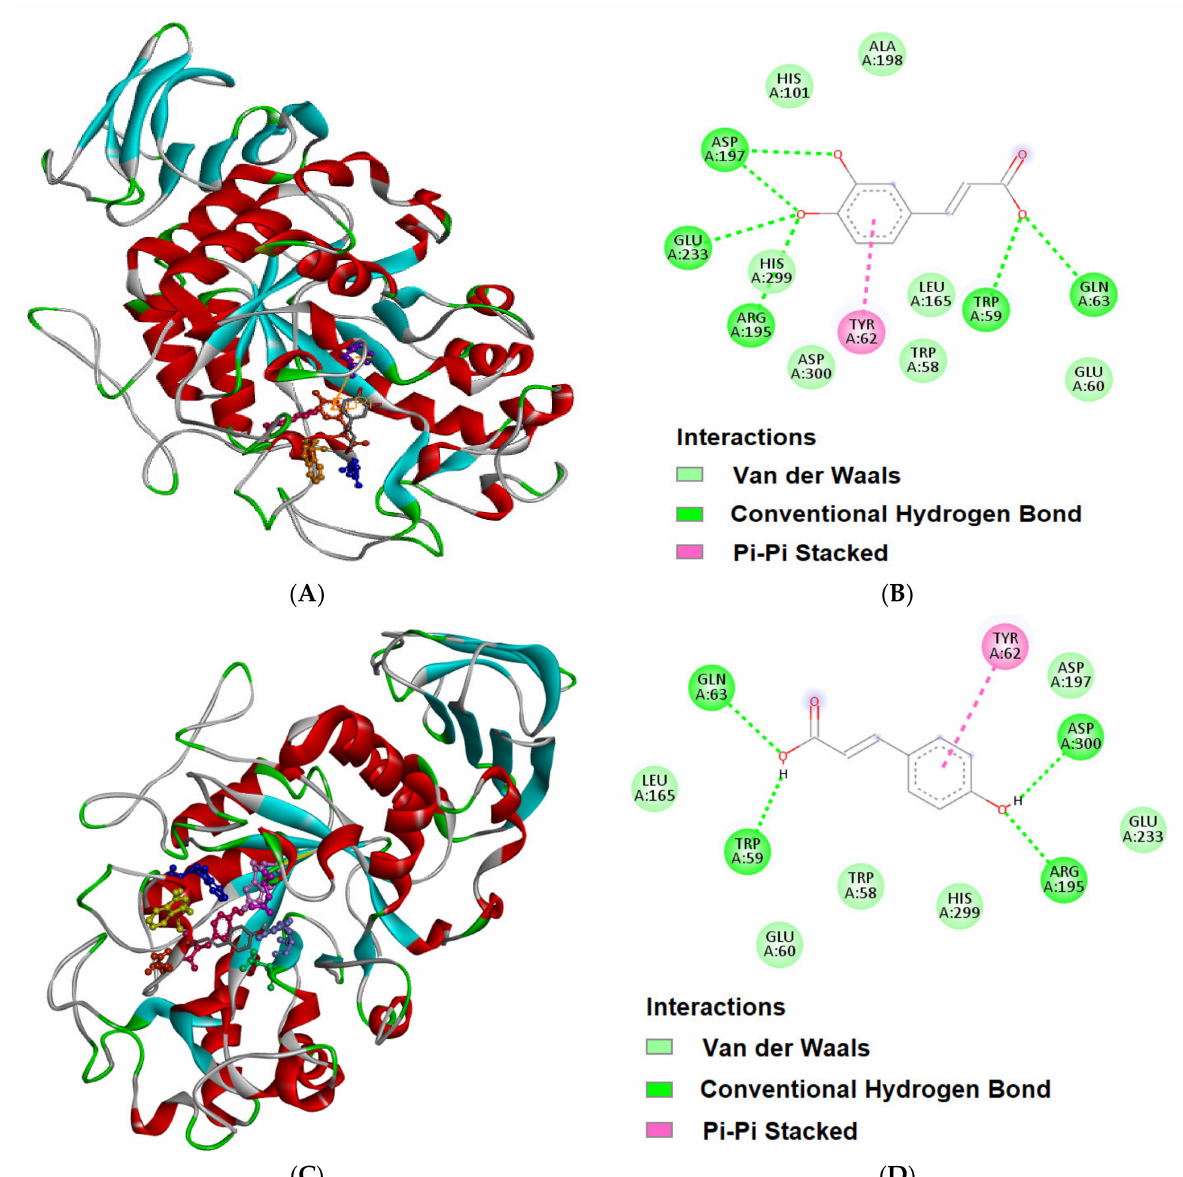
Figure 6. Molecular docking of caffeic acid with pancreatic α -amylase. ( A ) Binding of caffeic acid at the catalytic site of pancreatic α -amylase. ( B ) Amino acid residues and the types of forces in stabilizing the pancreatic α -amylase–caffeic acid complex (Discovery Studio). Similarly, for p-coumaric acid with α -amylase (Panels ( C , D